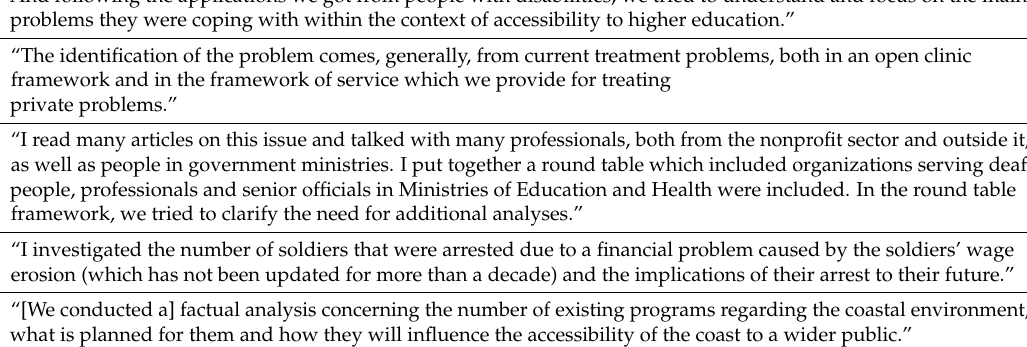
Table 2. Select Additional Responses to Identifying an